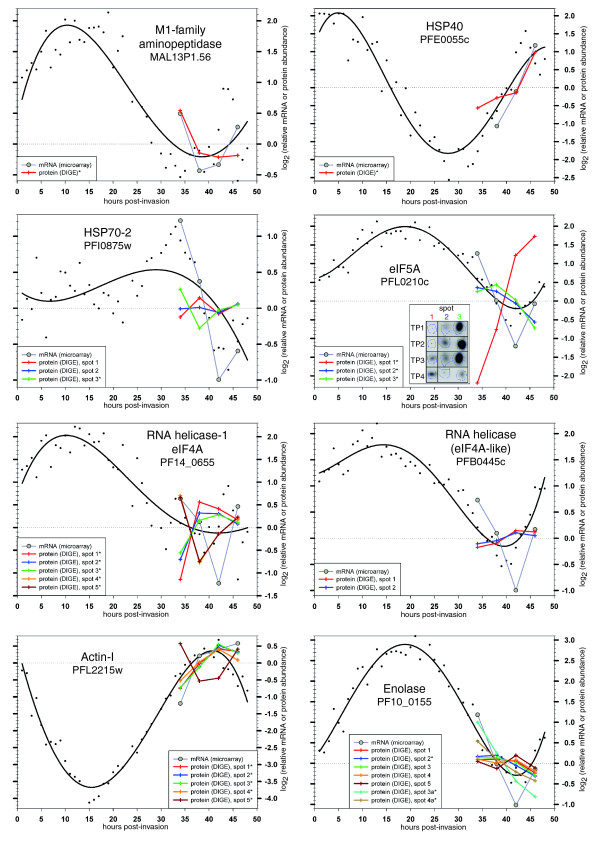
Expression profiles comparing relative mRNA and protein abundance. The panels summarize mRNA and protein abundance data for individual P. falciparum genes, with PlasmoDB accession numbers indicated below the gene names. Both the relative mRNA and protein abundance levels determined in this study for four schizont-stage time points (TPs) are based on the same parasite samples from a single large-scale in vitro culture and are indicated by gray and colored lines (see panel legends), respectively. In addition, the previously published transcript dynamics across the whole intra-erythrocytic life cycle [2] are included as black lines, with the black dots representing the corresponding raw data. All abundance profiles were mean-centered around zero based on the data points between 34 and 46 hours post-invasion. Asterisks in the panel legends denote cases for which analysis of variance (ANOVA) P < 0.01 and maximum fold change >1.4×. The insert in the eukaryotic initiation factor (eIF)5A panel depicts actual two-dimensional gel images to provide an approximate impression of absolute protein abundance levels between the three eIF5A isoforms.